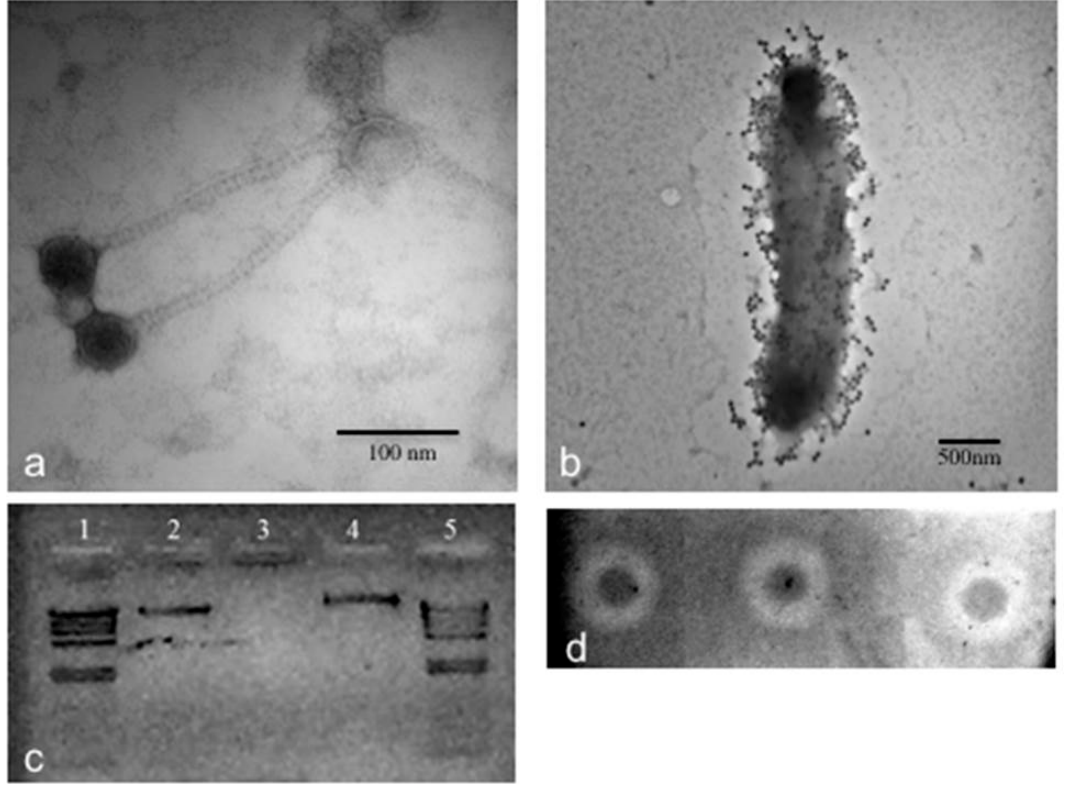
Figure 2. Microscopic, genomic, and phenotypic characterization of CG φ 29 phage. ( A ) TEM image of CG φ 29. Image was taken at 300,000X direct magnification. ( B ) TEM image of CG φ 29 phage infecting its Salicola host. Image was taken at 30,000X direct magnification. ( C ) Nucleic acid typing for CG φ 29. Lanes 1 and 5 contain λ phage control DNA cut with Hind-III. Lane 2 is uncut CG φ 29 nucleic acid, lane 3 is CG φ 29 nucleic acid treated with DNase and lane 4 is CG φ 29 nucleic acid treated with RNase. (D ) Spot assays of CG φ 29 on a lawn of CGM5-S host cells. The inverted and contrast-enhanced image